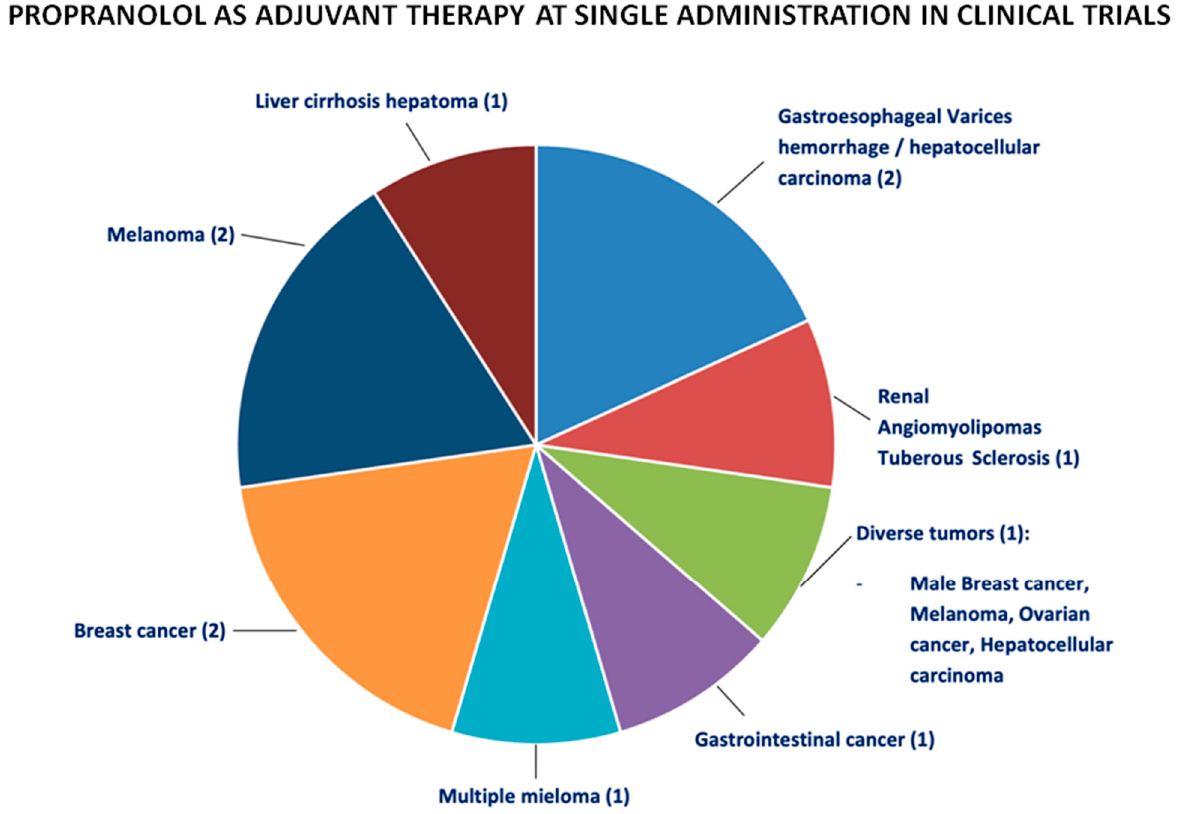
Figure 3. The distribution of the different clinical trials where propranolol has been used as adjuvant therapy at single administration for different types of oncological processes commented on in the main text. In brackets, the number of trials performed.